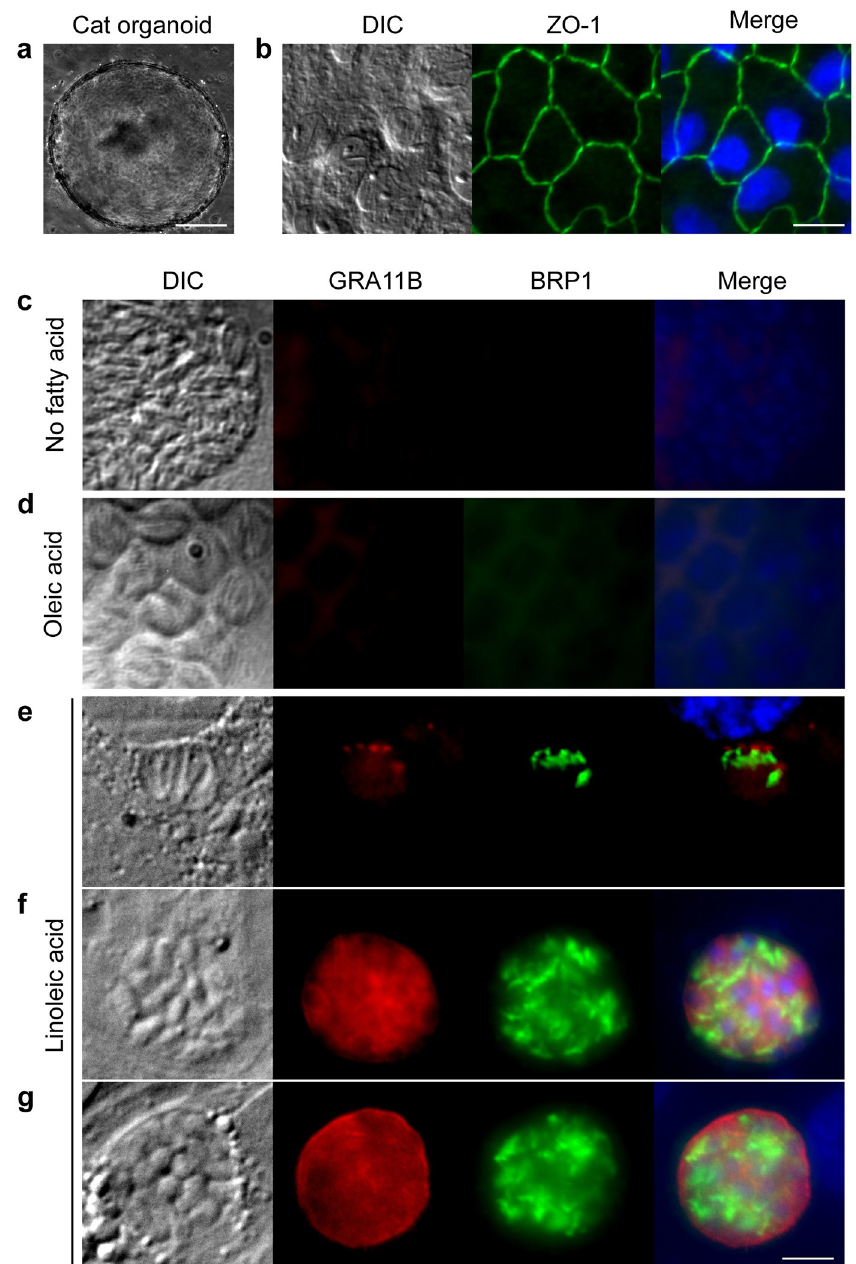
Fig 1. Linoleic acid enhances progression through the sexual stages. (a) Cat intestinal organoids were generated from small-intestine sections and were grown in basement membrane matrix. Example of a growing organoid, 100- μ m size bar. (b) Intestinal organoids were dissociated using trypsin and single cells seeded onto glass coverslips to grow as monolayers. The cells in the monolayer expressed the tight junction protein ZO-1 (green), 20- μ m size bar. Cat intestinal monolayers were incubated with either (c) no fatty acid supplementation, (d) 200 μ M oleic acid, or (e, f, g) 200 μ M linoleic acid for 24 hours and then infected with ME49 bradyzoites for 5 days. Parasites undergoing presexual development were commonly seen only with linoleic acid supplementation as marked by staining with GRA11B (red) or BRP1 (green). Parasites in (e) early, (f) middle, or (g) late stages of sexual development were noted by differential localization of GRA11B. All panels are 20 μ m 2 with a 5- μ m white size bar in the lower right corner. BRP1, bradyzoite rhoptry protein-1; DIC, differential interference contrast; GRA11B, dense granule protein 11B; ZO-1, zona occludens